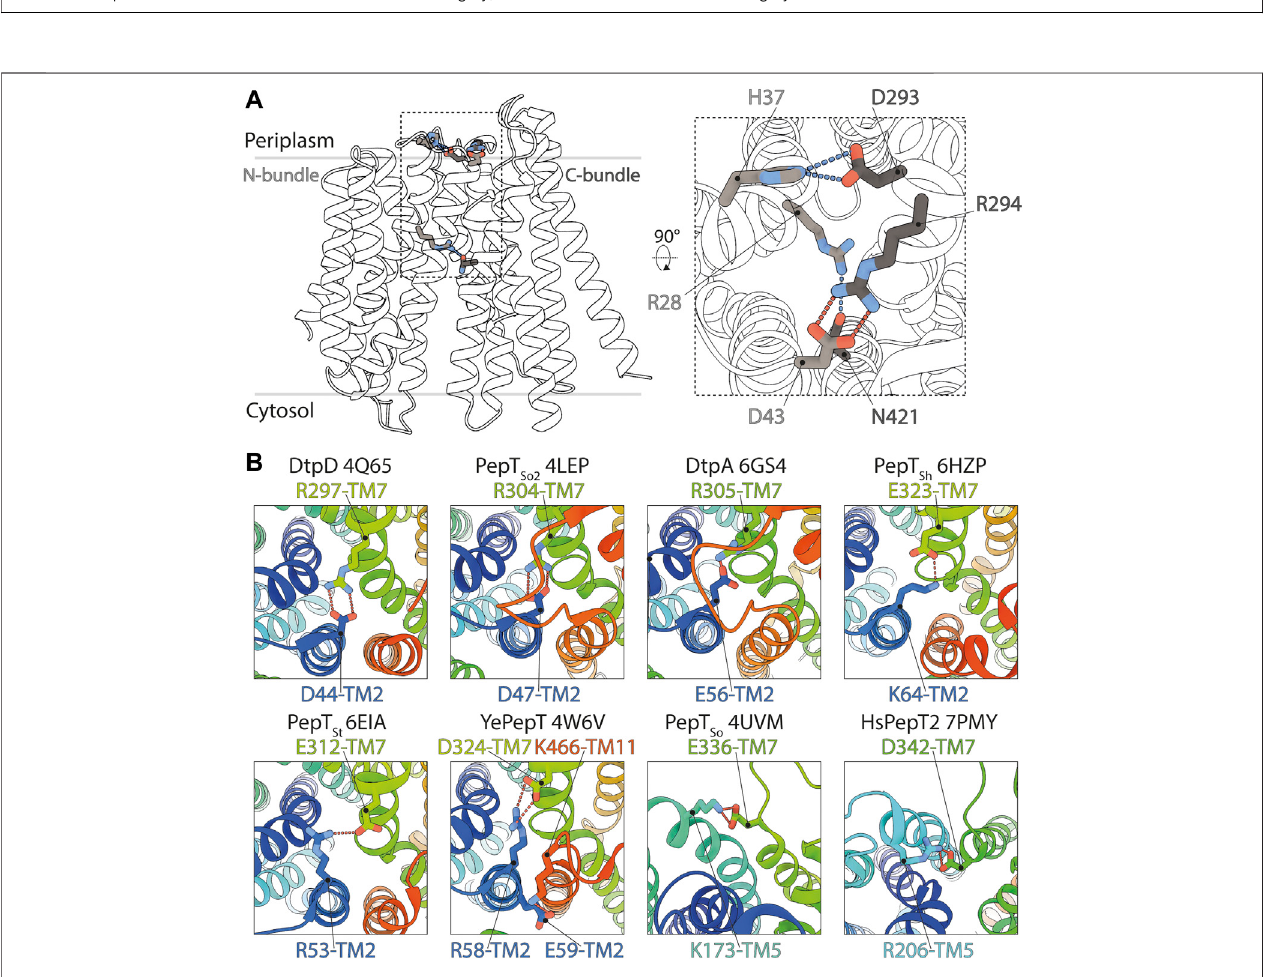
FIGURE 6 | Structural basis for the stabilization of the inward facing state in DtpC and other POT homologues. (A) The salt bridge and hydrogen bonds favoring closureofthetwobundlesontheperiplasmicsideofDtpCarerespectivelyshownasredandbluedashes. (B) ThestructuresofhomologousPOTsfrom Escherichiacoli (DtpD, DtpA), Shewanella oneidensis (PepT So2 , PepT So ) Staphylococcus hominis (PepT Sh ), Streptococcus thermophilus (PepT St ), Yersinia enterocolitica (YePepT) and Homo sapiens (HsPepT2), were all previously captured in the IF state. Here they were analyzed to identify the strongest interaction stabilizing their common conformation. The structures are colored from blue to red, from their N- to C-termini, and the respective PDB accession numbers are indicated. Conserved salt bridges are labelled and highlighted by red dashed